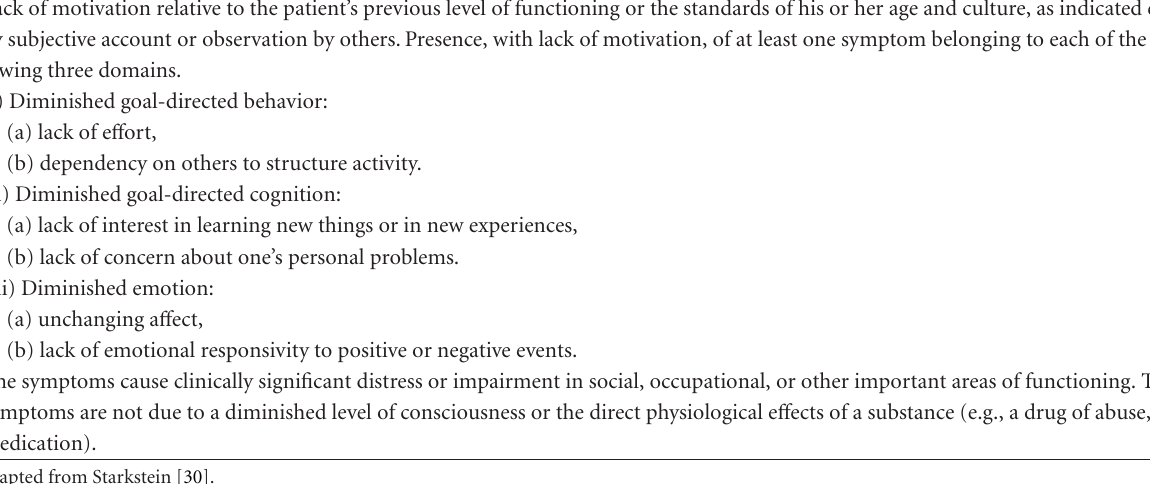
Table 1: Diagnostic criteria for apathy.